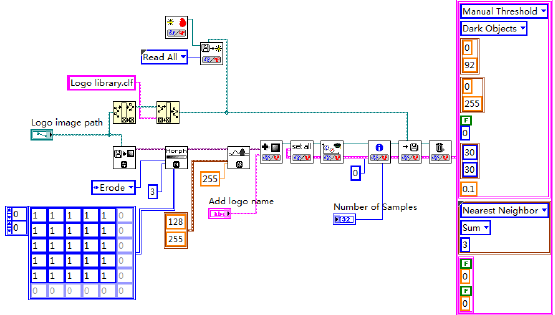
Figure 8. Program block diagram of addition of the sample.